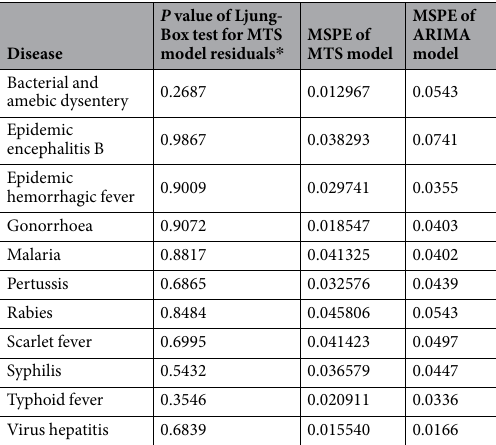
Table 2. The goodness-of-fit results of MTS and ARIMA model for each disease. * The significance level α was set to be 0.05 in advance. The null hypothesis of Ljung-Box test declared that the testing series to be white noise, thus it was reasonable to say the model was good at fitting if such null hypothesis for its corresponding residual series could not be rejected.